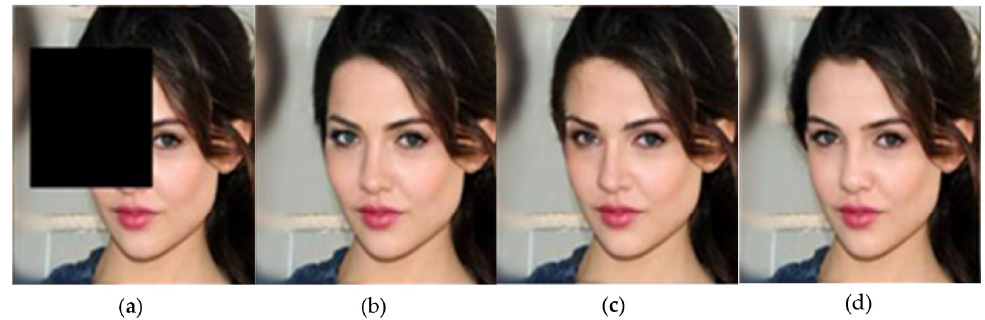
Figure 8. Image inpainting performance comparison with/without Diet-PEPSI unit. ( a ) Image with Mask; ( b ) Image with Mask; ( c ) Without Diet-PEPSI; ( d ) Source image.